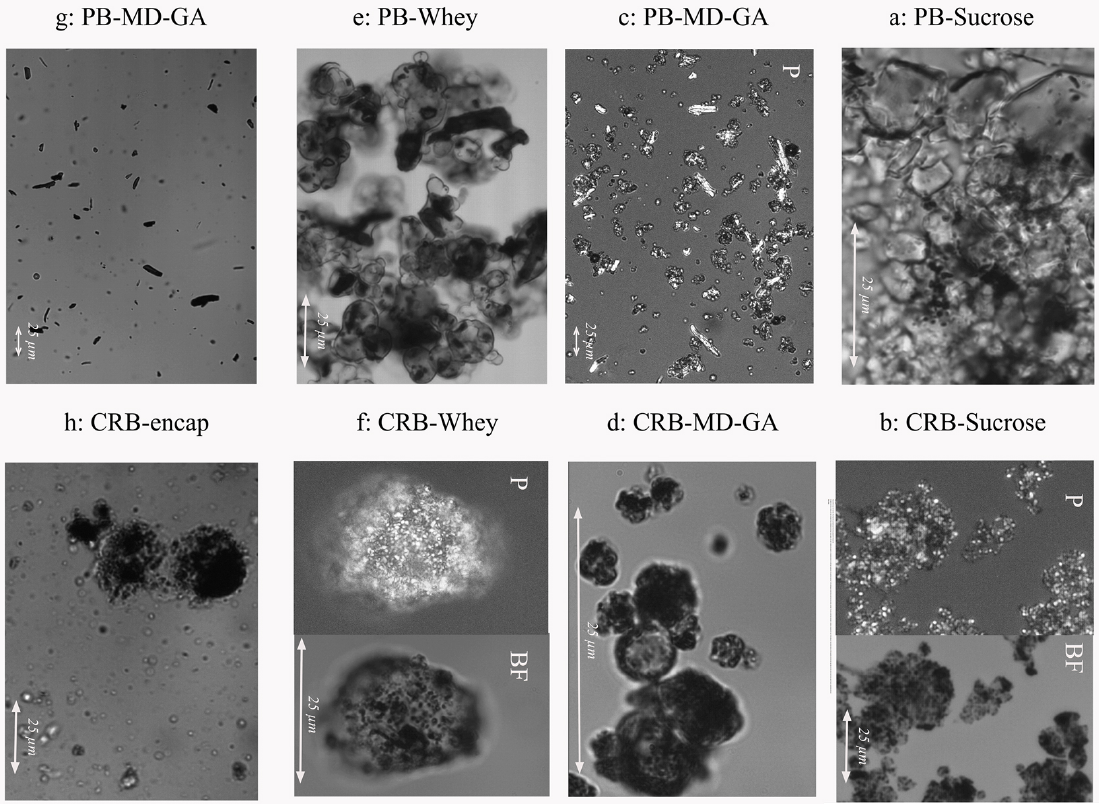
Figure 5. Light microscope images of pure bixin and CRB microcapsules imbibed in MCT oil. ( a ) PB-Sucrose, non-polarized light × 100; ( b ) CRB-Sucrose, non-polarized (left) and polarized light (Right) × 50; ( c ) Bi-MD-GA, polarized light, × 50; ( d ) CRB-MD-GA, non-polarized light, × 100; ( e ) PB-Whey, non-polarized, × 50; ( f ) CRB-Whey, non-polarized (left) and polarized light (Right), × 100; ( g ) PB-MD dispersed in water, non-polarized light, × 20; ( h ) PB-MD dispersed in water, × 50; ( g , h ) are representative images of all the water dispersions of spray dried systems containing PB